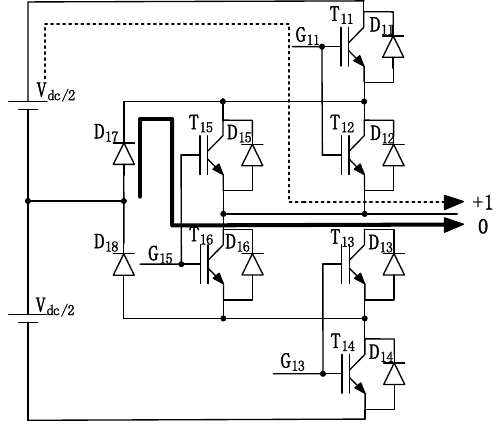
Figure 9. ID3 type ( α = +1, M ≈ 0).